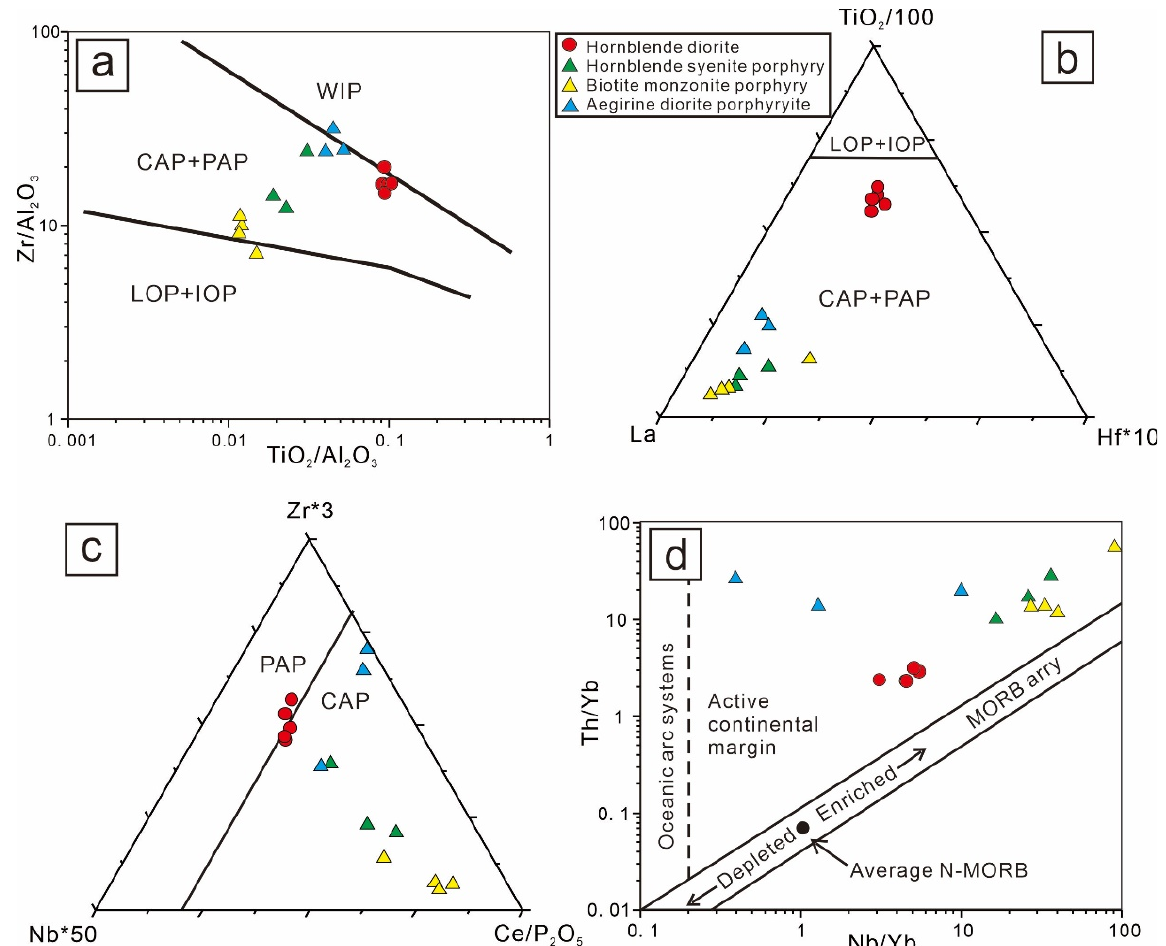
Figure 14. (a – d) Tectonic discrimination diagrams. ( a ) Zr/Al 2 O 3 versus TiO 2 /Al 2 O 3 diagram, modified after [104]. ( b , c ) TiO2-La-Hf diagram and Zr-Nb-Ce/P 2 O 5 diagram, modified after [104,105]. ( d ) Nb/Yb versus Th/Yb diagram, modified after [96]. CAP = continental arc potassic rocks; PAP = post-collisional arc potassic rocks; IOP = initial oceanic arc potassic rocks; LOP = late oceanic arc potassic rocks.